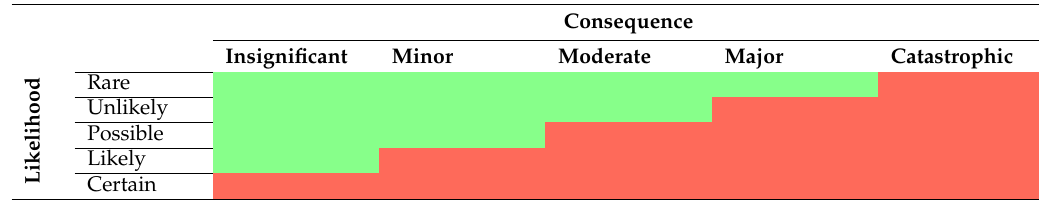
Table 13. Risk Evaluation